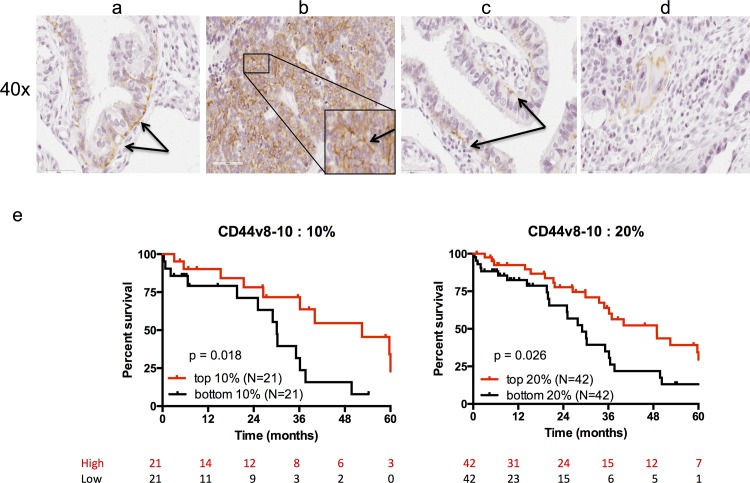
Immunohistochemical and survival analysis of CD44v8-10 expression in High Grade Serous Ovarian Cancer Tumor Tissue Microarrays (TMAs).Fixed paraffin embedded tissue microarray cores were stained by immunohistochemistry using an antibody against CD44v9, scanned using an Aperio Scanscope, and analyzed using Aperio Imagescope software positive pixel count algorithm. Representative images taken at high (40x) power show basal epithelial staining in a and c, more diffuse surface epithelial staining in b, and negative stroma with isolated positive epithelial cells in d. e.) Overall Survival of patients with high-grade serous ovarian carcinoma by CD44 variant expression. Left- Highest and Lowest 10% expression variant and Right- Highest and Lowest 20% of expression of variant, demonstrates significant overall survival in the highest expressers with p = 0.0181 and p = 0.0262, respectively.